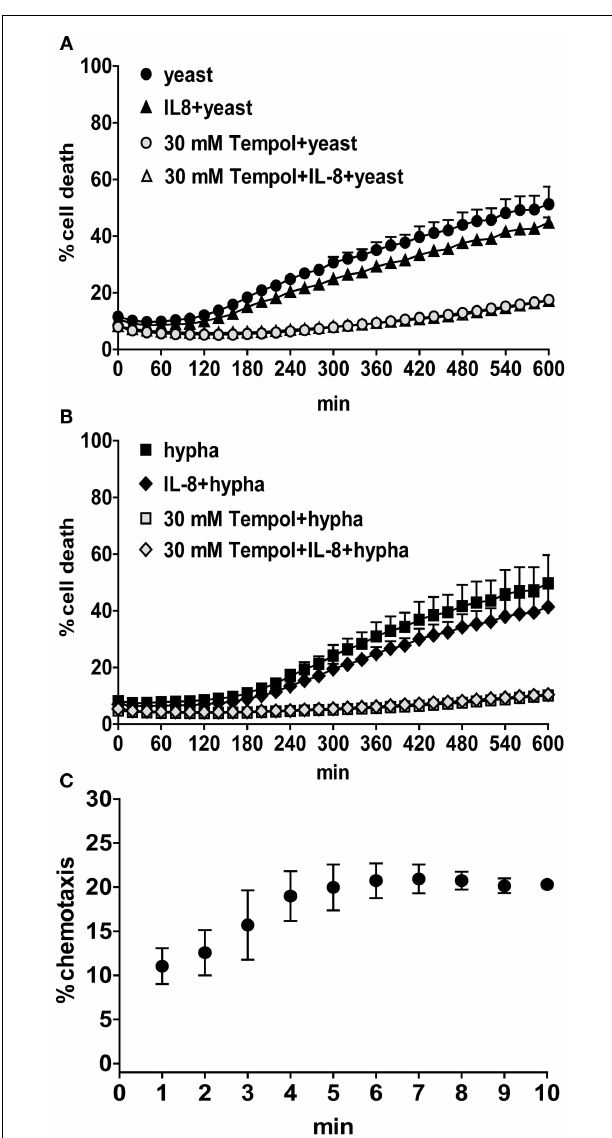
FIGURE 8 | During infection with C. albicans IL-8 does not enhance neutrophil NET formation. The rate of cell death of PMNs treated with 100nM IL-8 for 30min prior to infection with C. albicans (MOI 3) was analyzed over a period of 10h by measurement of DNA-staining by the cell-impermeable dye Sytox Green.The Y -axis represents the relative amount of dead cells after normalization to the lysis control (100%). Background values (unstimulated cells) were subtracted from all values. Black symbols: PMNs infected with yeast [ (A) , circles and triangles] or hyphal cells [ (B) , squares and rhombuses] and additionally with IL-8 (triangles and rhombuses); gray symbols: PMNs additionally treated with 30mMTempol. One representative experiment out of three independent experiments with three different donors is shown. Data are presented as means of three technical replicates ± SD. Neutrophil chemotaxis was measured in a transwell assay (C) .The Y -axis represent the percentage of neutrophil migration toward 10nM IL-8 normalized to 100% florescent labeled cells.The base line levels (migrated cells without chemoattractant) were subtracted from all values. One representative experiment out of three independent experiments with three different donors is shown. Data are presented as means of three technical replicates ±